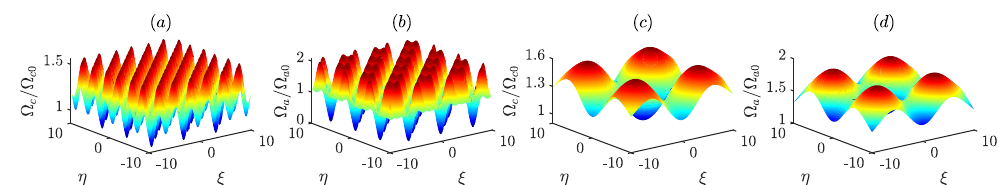
Figure 2. Spatial distributions of the control and assistant laser fields in the Rydberg-dressed EIT system for realizing optical potentials with and without PT symmetry. Distributions of the control field Ω c ( a ) and assistant field Ω d ( b ) of Equations (12) and (13) as functions of dimensionless spatial coordinate ξ = x / R ⊥ and η = y / R ⊥ for realization of the 2D PT -symmetric optical potential V po,1 with V 0 = 1. Distributions of the control field ( c ) and assistant field ( d ) of Equations (15) and (16) as functions of ξ and η for realizing the non- PT -symmetric potential V op,2 ( ξ , η ) with a = 0.01, F 0 = G 0 = 7, σ 1 = σ 2 = 5. Here, Ω c 0 = 2.0 × 10 7 s − 1 , Ω d 0 = 1.5 × 10 7 s − 1 , R ⊥ = 5 µ m, and L diff = 0.33mm,